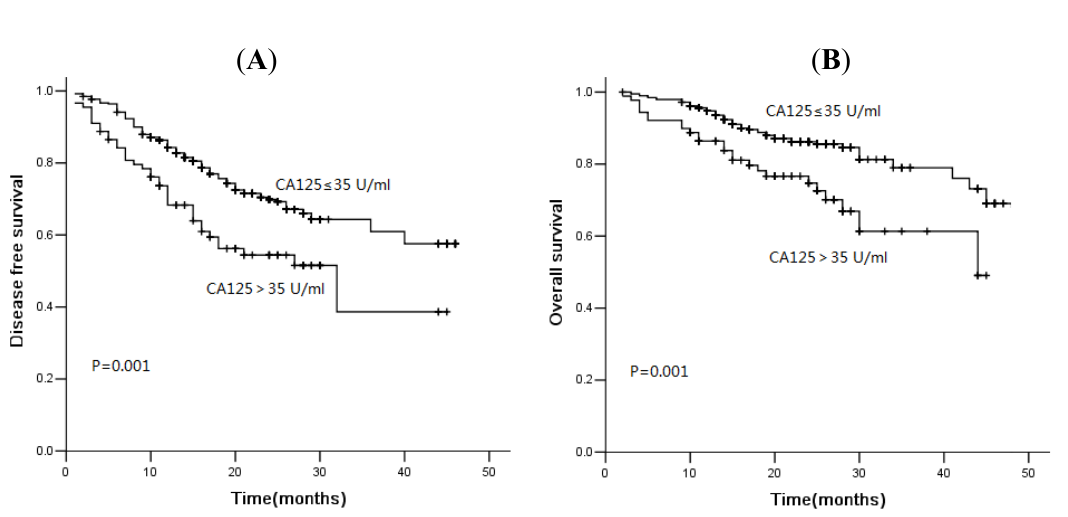
Figure 1. Kaplan-Meier disease-free survival curves ( A ) and overall survival curves ( B